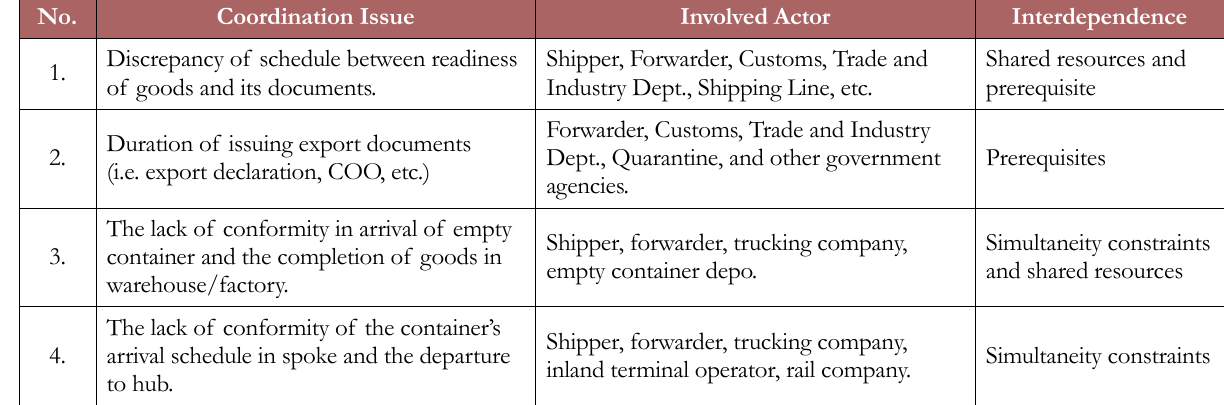
Table 2. Coordination Issues in Hub-and-Spoke of Export